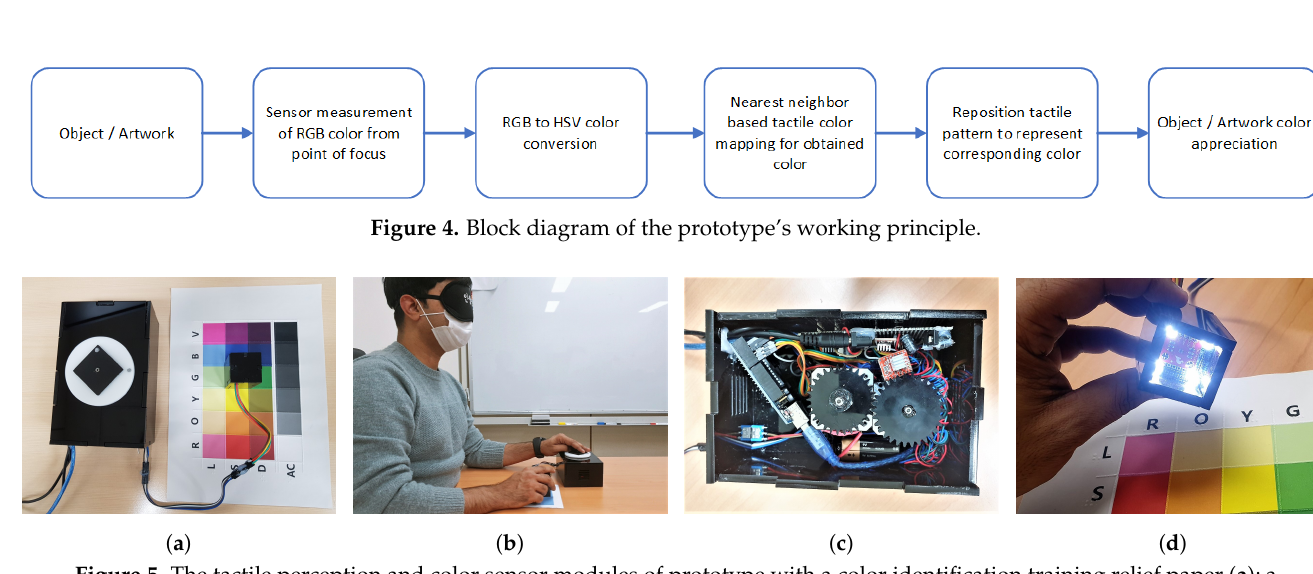
Figure 5. The tactile perception and color sensor modules of prototype with a color identification training relief paper ( a ); a demonstration of the prototype in use ( b ); the internal hardware for tactile perception and color sensor modules ( c , d